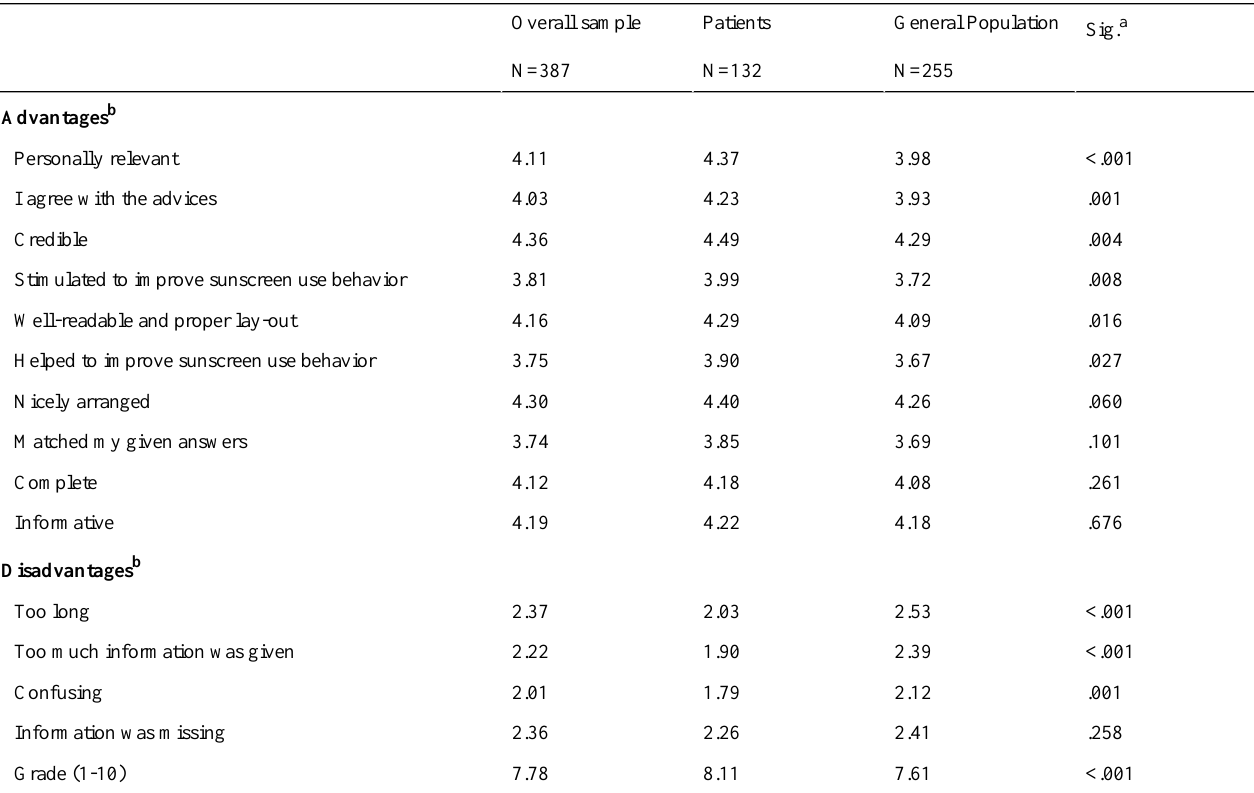
Table 4. Program evaluation based on skin cancer history.